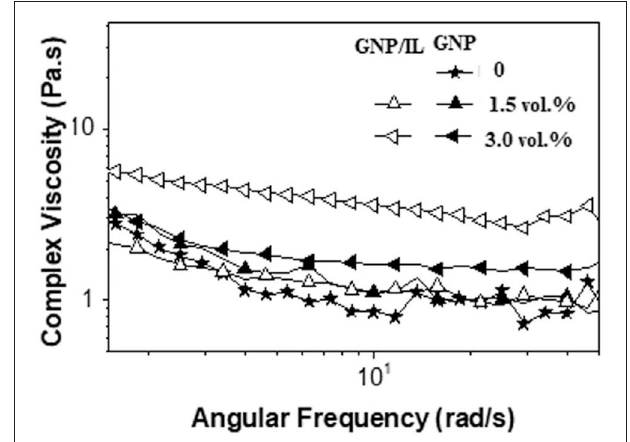
FIGURE 3 | Dependence of complex viscosity with frequency for the neat ER and the corresponding ER/MTHPA dispersions loaded with 1.5 and 3.0 vol.% of GNP or GNP/IL. TABLE 3 | AC electrical conductivity of epoxy-based composites loaded with different amounts of GNP. GNP content